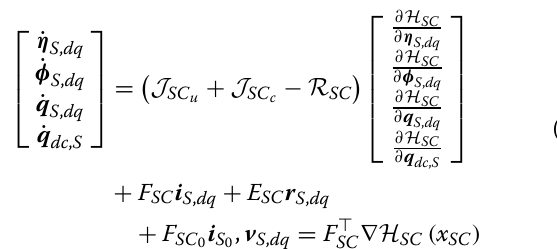
Fig. 6 Microgrid in grid-connected mode